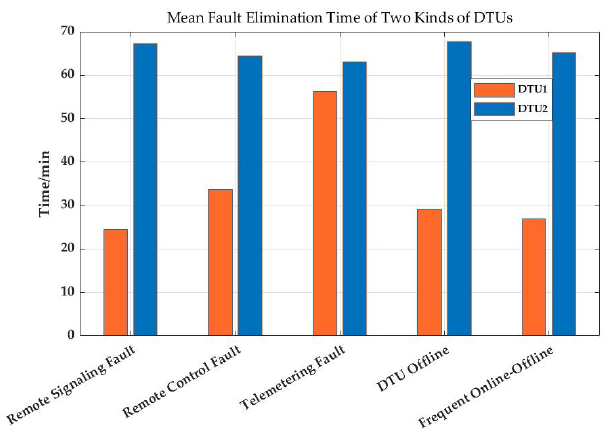
Figure 8. Mean fault elimination time of two groups of DTUs.